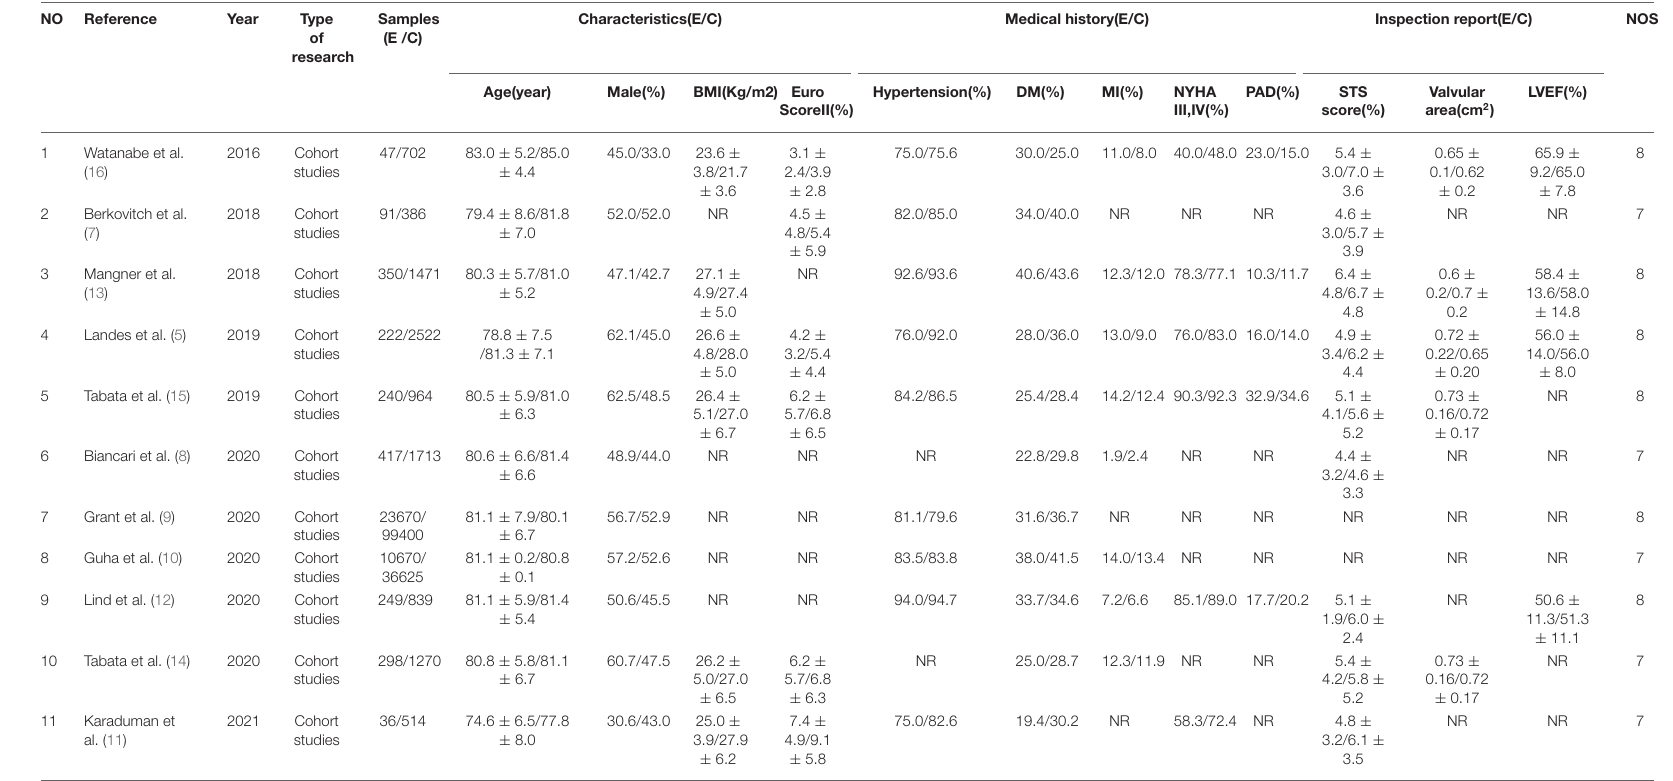
TABLE 1 | Characteristics of the studies included in this